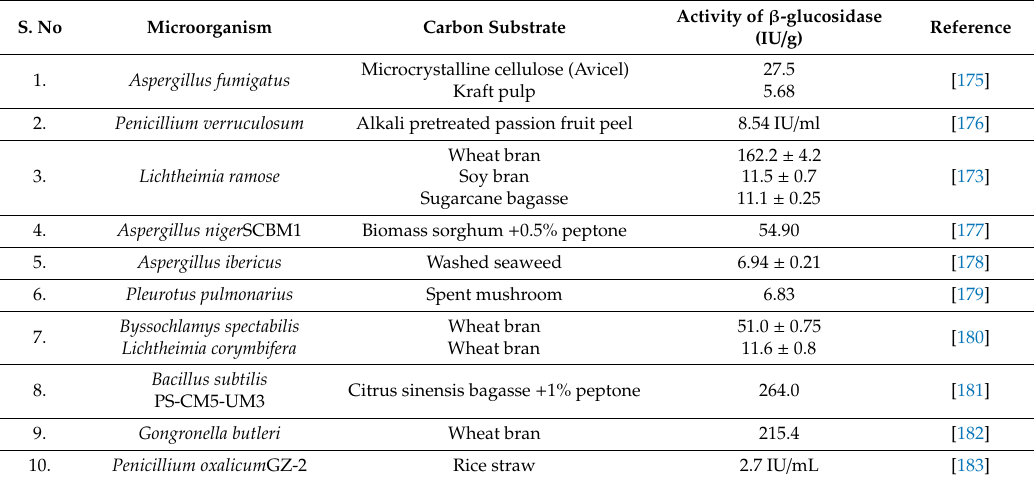
Table 2. Numerous studies on the production of β -glucosidase using di ff erent types of